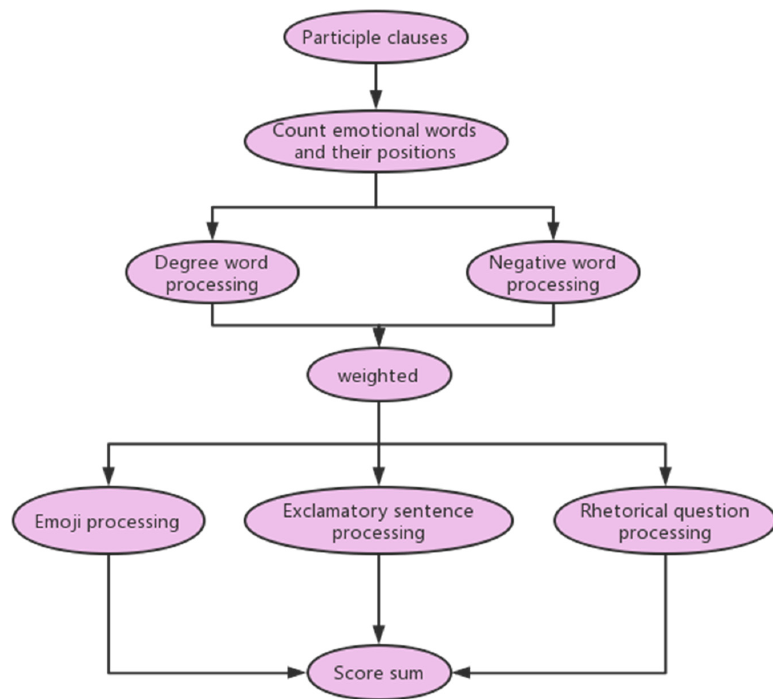
Figure 1. Emotion analysis flow chart.